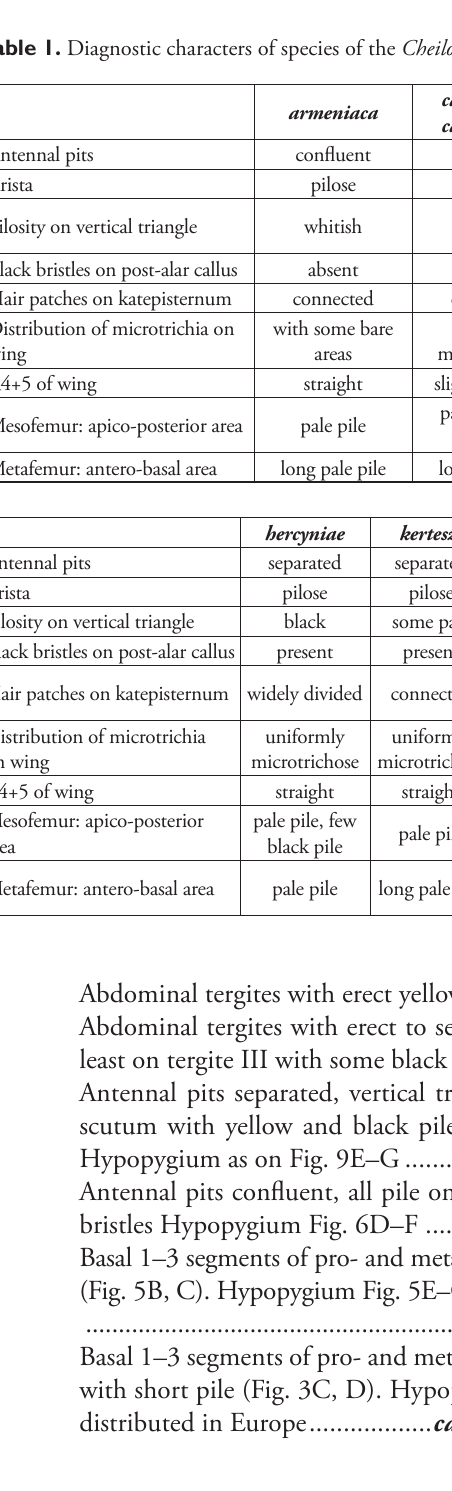
Table 1. Diagnostic characters of species of the Cheilosia caerulescens group and Cheilosia hercyniae